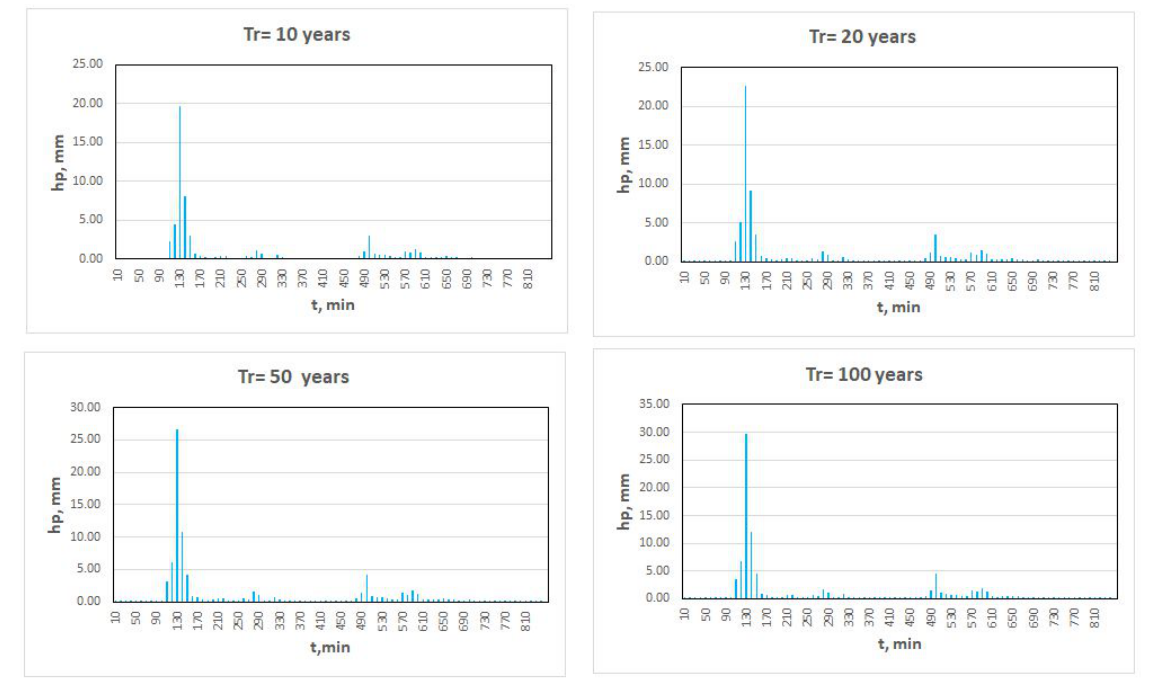
Figure 7. Hyetographs for flash floods. Cuautepec Basin Tr = 2, 5, 10, 20, 50 and 100 years. 3.2. Simulation of the Historic Flood Using Hec-HMS Flood simulation using the Hec-Hms semi-distributed model produced the hydro- graph shown in Figure 8.